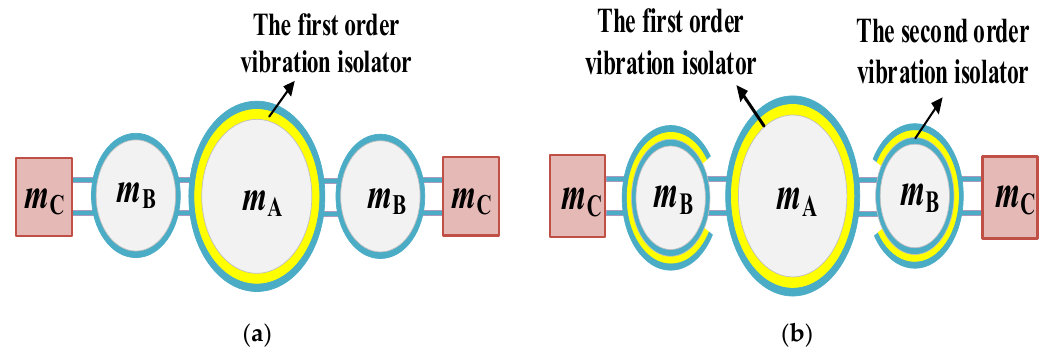
Figure 4. Simplified structures of the AUG with ( a ) the single-stage vibration isolator and ( b ) the two-stage vibration isolator.